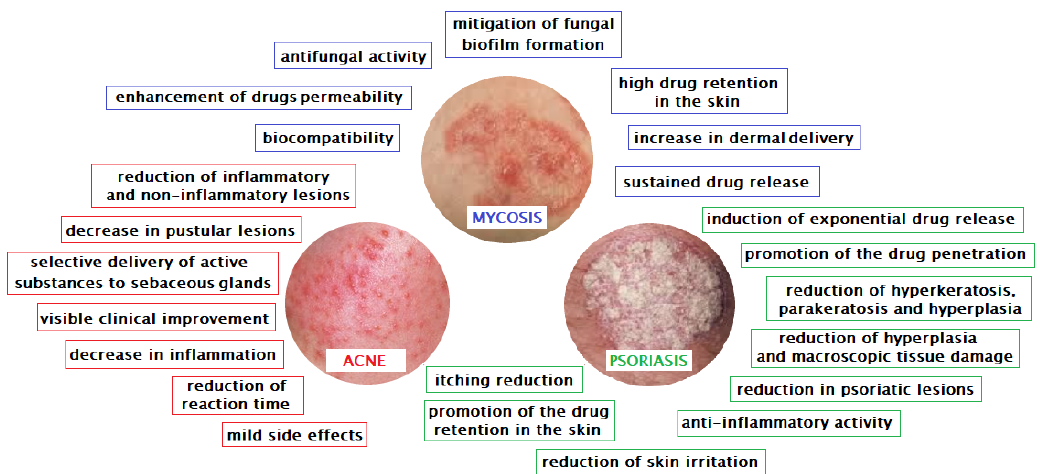
Figure 1. The e ff ects of hydrogels in the treatment of selected skin Figure 1. The effects of hydrogels in the treatment of selected skin diseases.